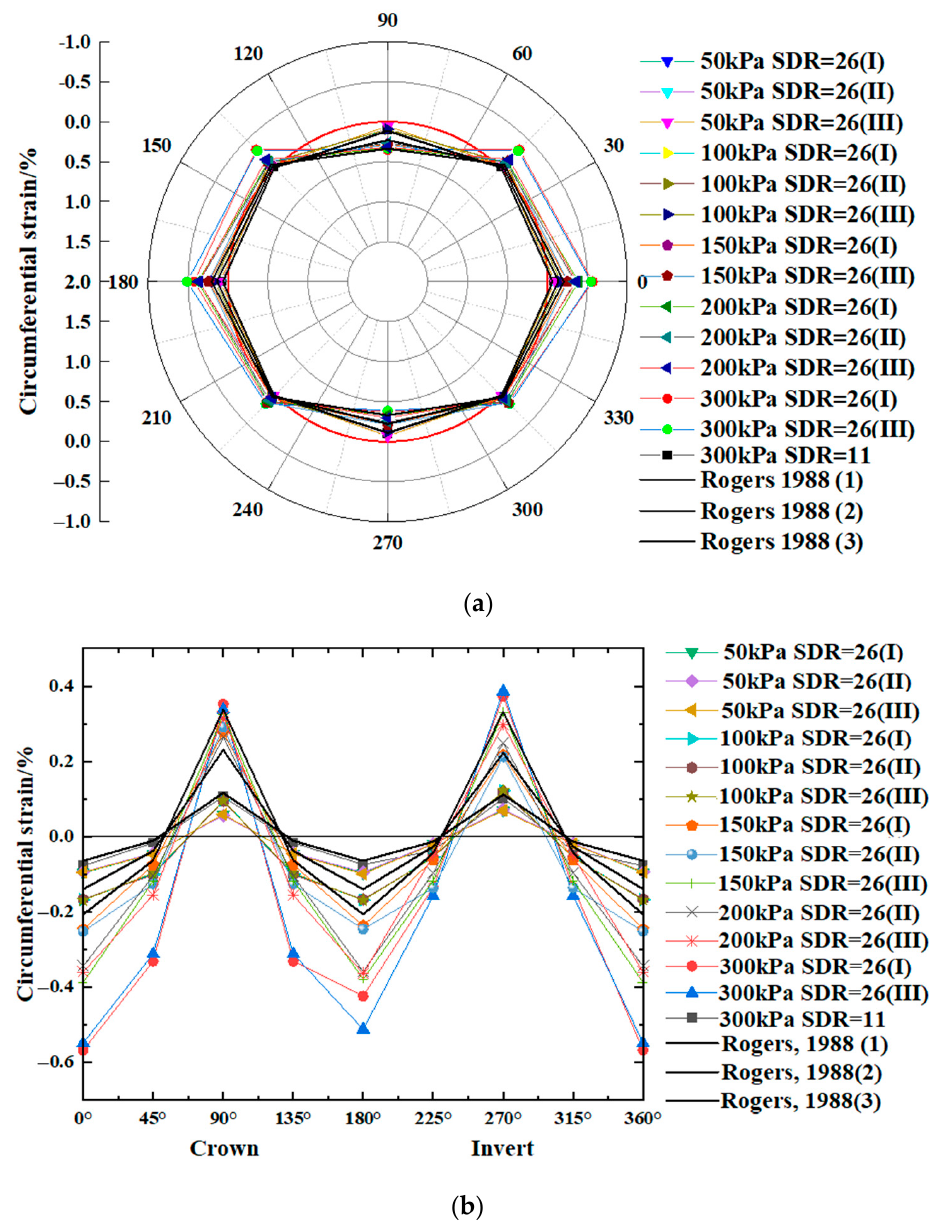
Figure 2. Strain profiles for the load test: ( a ) circular axis; ( b ) linear axis.